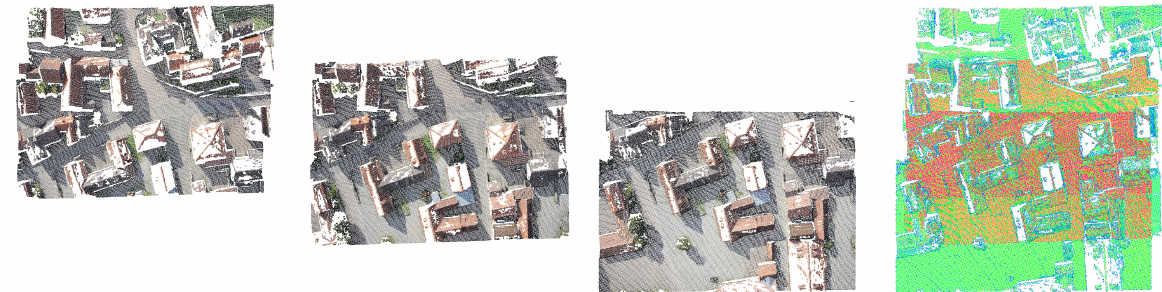
Figure 5. The left three images show the reduced point clouds derived from three disparity maps. On the right the coded point cloud representing inlier probabilities derived by means of an occupancy grid is given. The overlapping region in the center has higher probabilities as it has votes from three point clouds. Only the red points are contained in all of the three input point clouds and, hence, have the highest probability.